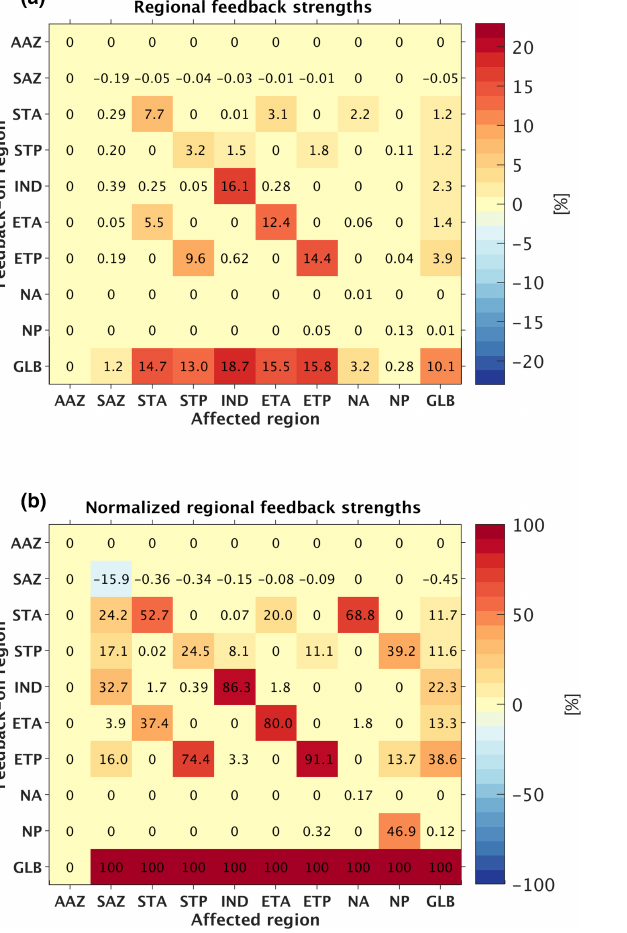
Figure 10. (a) Regional mean feedback strength due to the PSR negative feedback effect within each individual region. The y axis denotes the single region (or the entire ocean in the case of “GLB” meaning global) within which the PSR feedback was turned on, while the x axis denotes the region affected. A feedback strength above 0 indicates a negative PSR feedback effect (i.e., a reduction in export change when the PSR feedback is applied). (b) Percent con- tribution of each individual region to each region’s total PSR feed- back strength, computed as the regionally derived feedback strength within an affected region divided by the globally derived feedback strength in the same affected region (i.e., each given grid cell in (a) is divided by the corresponding column’s bottommost grid